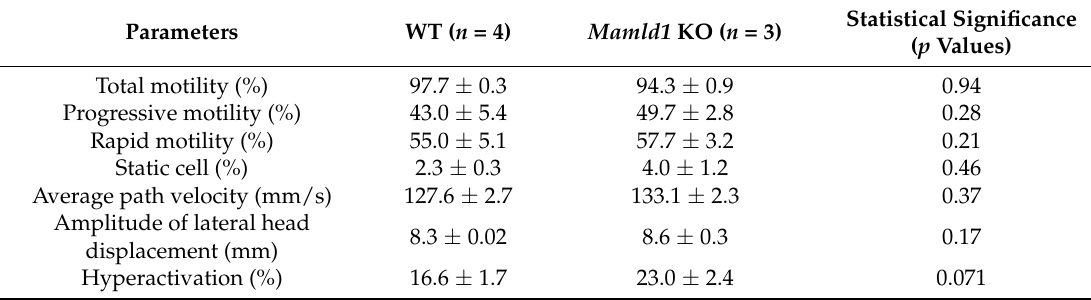
Table 3. Qualitative assessment of sperm of mice at 8 weeks of